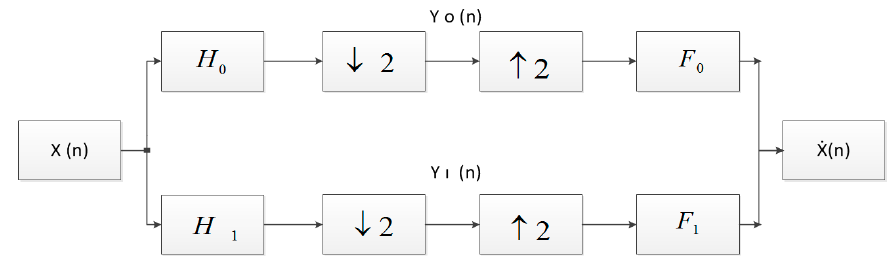
Figure 1. Two-channel set of discrete wavelet transform filters.